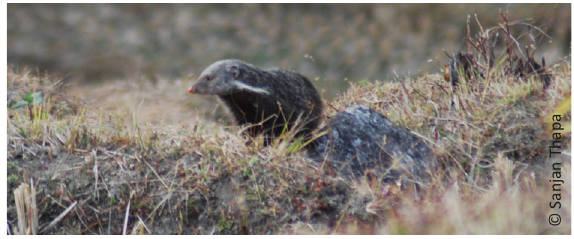
Image 13. Crab-eating Mongoose Herpestes